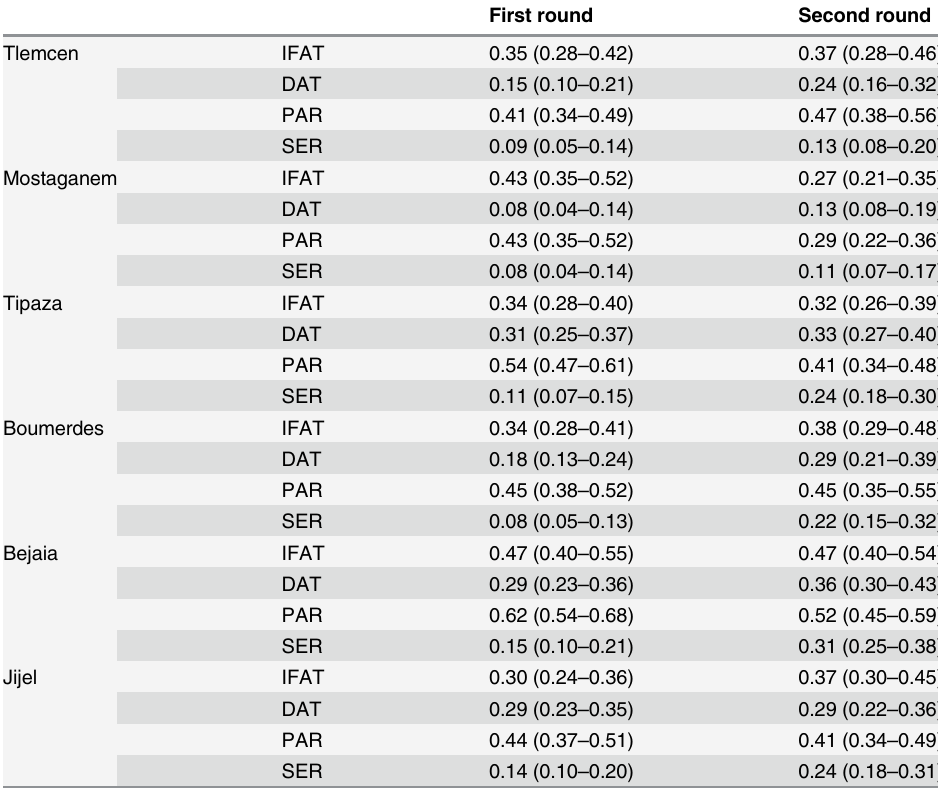
Table 3. Apparent prevalences with 95% confidence interval per locality, sampling phase and test: IFAT = indirect immunofluorescence test; DAT = direct agglutination test; PAR = parallel interpreta- tion of the two test results; SER = serial interpretation of the two test